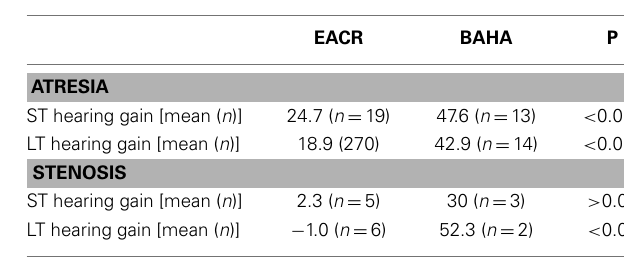
Table 9 | Comparison of short and long-term hearing gain in atresia and stenosis subjects